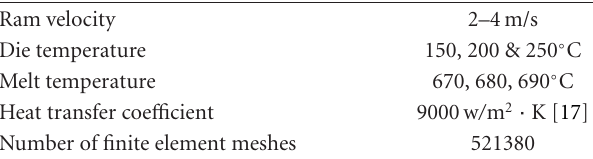
Table 2: Initial and boundary